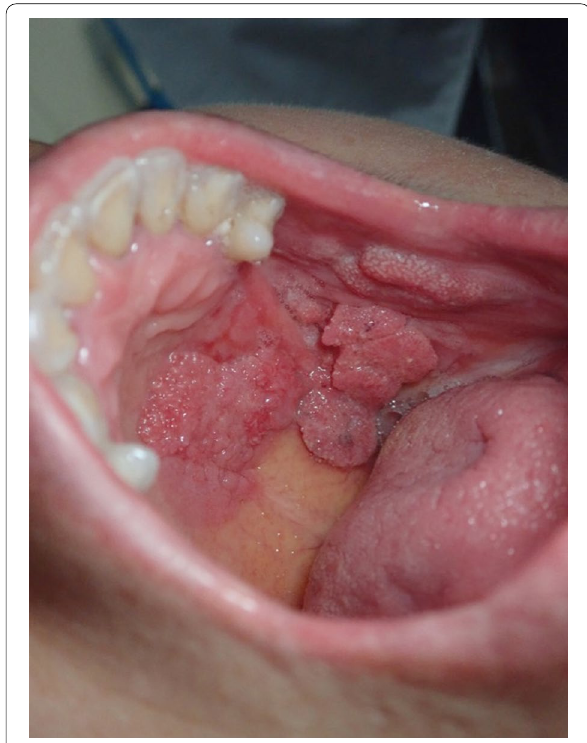
Fig. 1 The manifestations of oral cavity